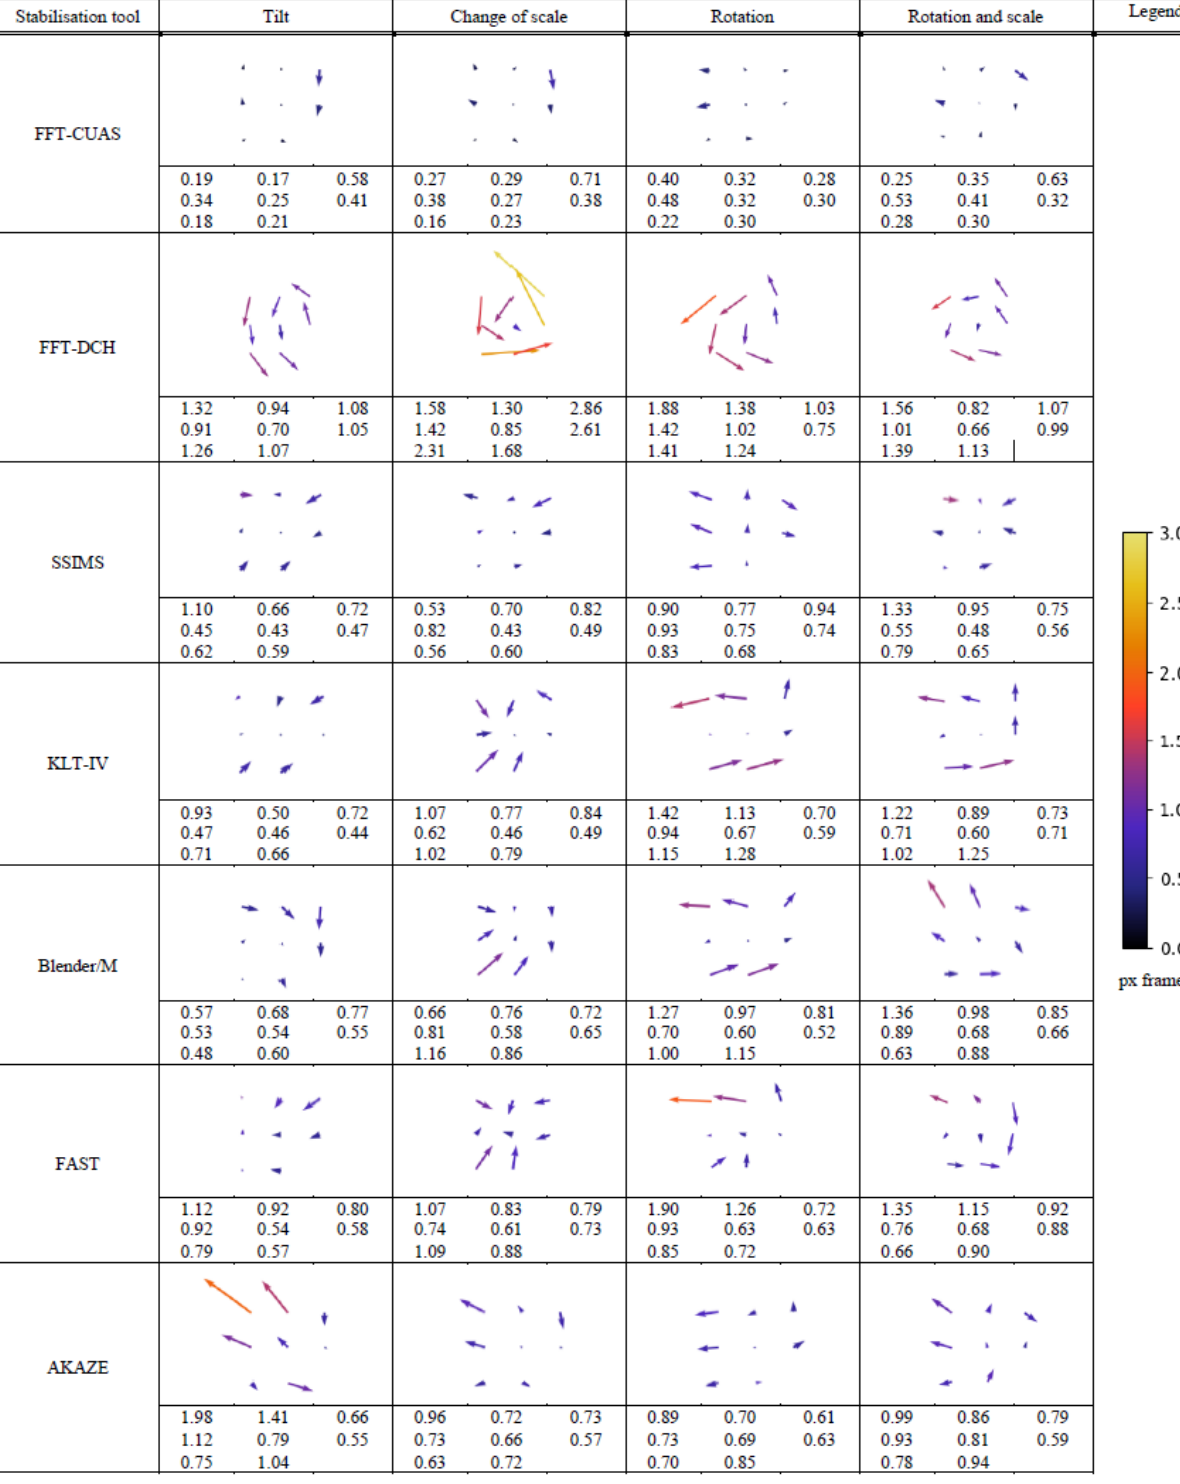
Table 3. Aggregated SVF analysis results of the stabilised videos for the Kolubara case study. The mean u and v components of the residual motion of static features in eight subregions are illustrated by vector size and orientation, whereas numeric values illustrate the mean residual velocity magnitude for each